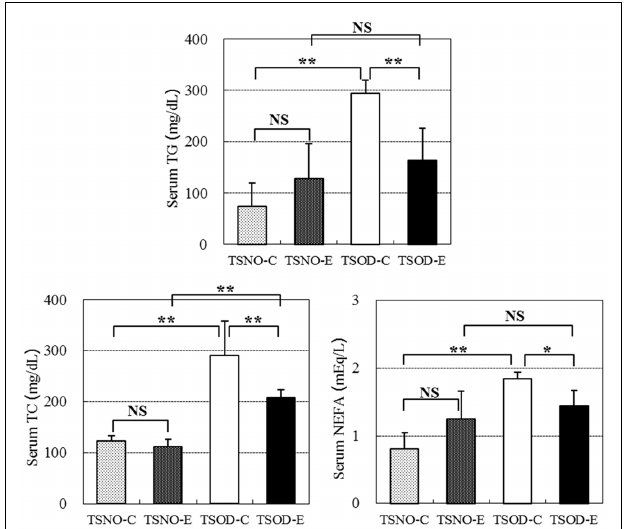
FIGURE 2 | Comparisons of serum lipids. SerumTG,TC, and NEFA concentrations were assayed. One and two asterisks indicate the p value less than 0.05 and 0.01, respectively and NS indicate no significance between the groups.